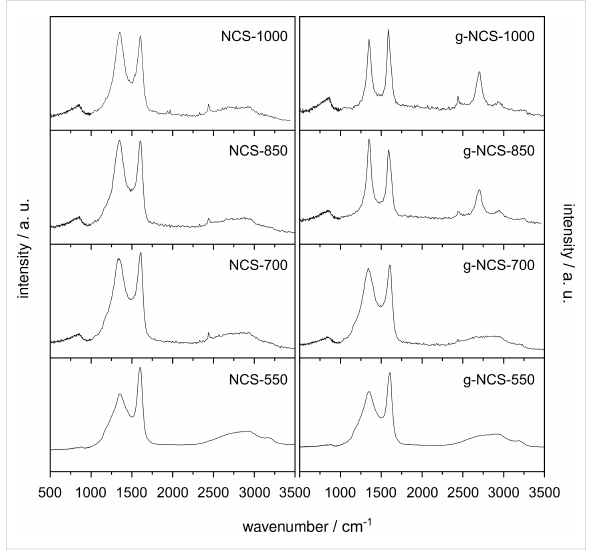
Figure 6: Raman spectra of the NCS and g-NCS catalysts (the x -axis represents the Raman shift relative to the excitation laser wavelength given in cm − 1